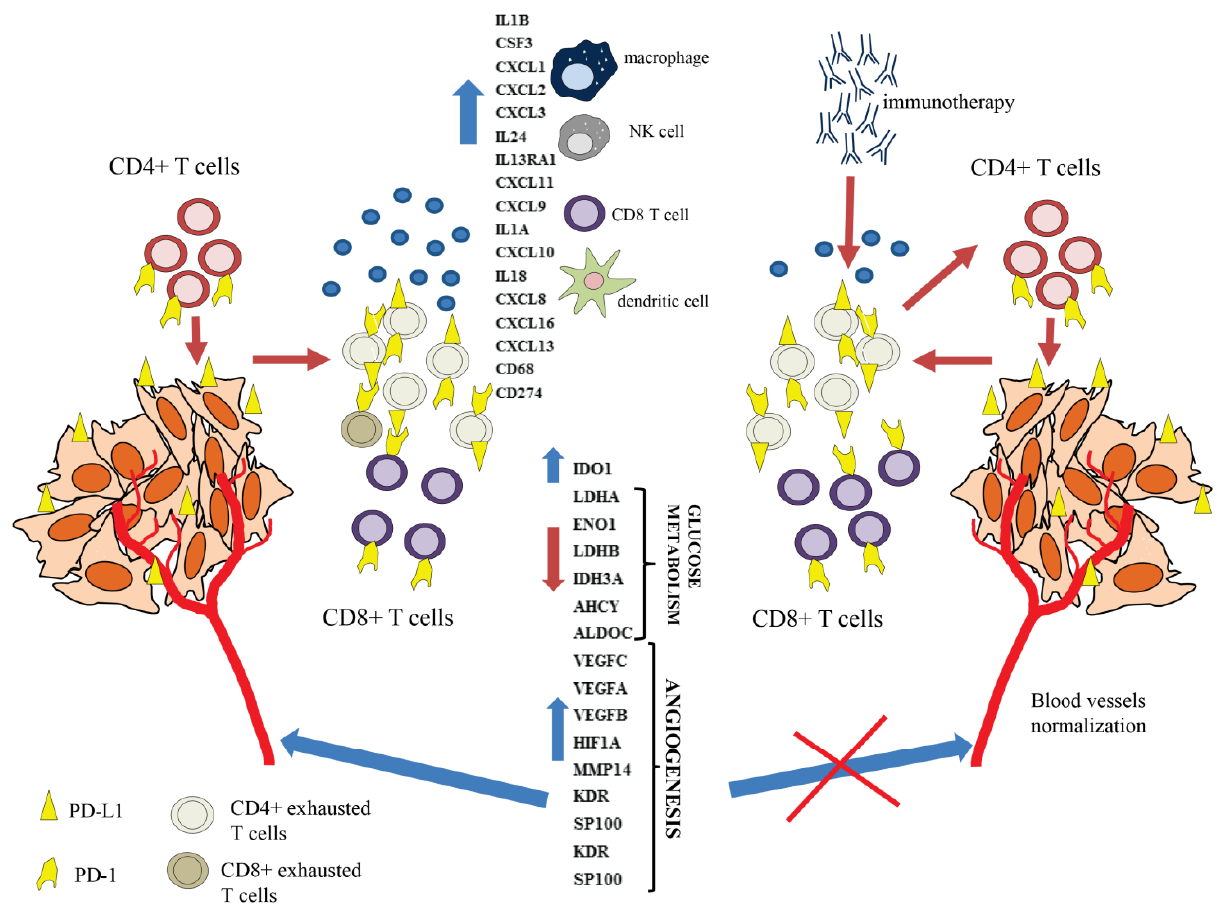
Figure 8. Based on our results, we postulate that persistently activated CD4 + T cells co-cultured with cancer cells become exhausted and overexpress various cytokine-encoding genes, which may facilitate recruitment of other immune cells such as the effector CD8 + T cells to the tumor microenvironment (TME). The CD4 + T cells during the exhaustion process express PD-L1 on their surfaces, which likely leads to elimination or exhaustion of effector CD8 + T cells. Additionally, exhausted CD4 + T cells may eliminate or exhaust other CD4 + T cells in TME and overexpress the proangiogenic factors. Immunotherapy activates exhausted CD4 + T cells, reducing the levels of proangiogenic factors and leading to blood vessels normalization.